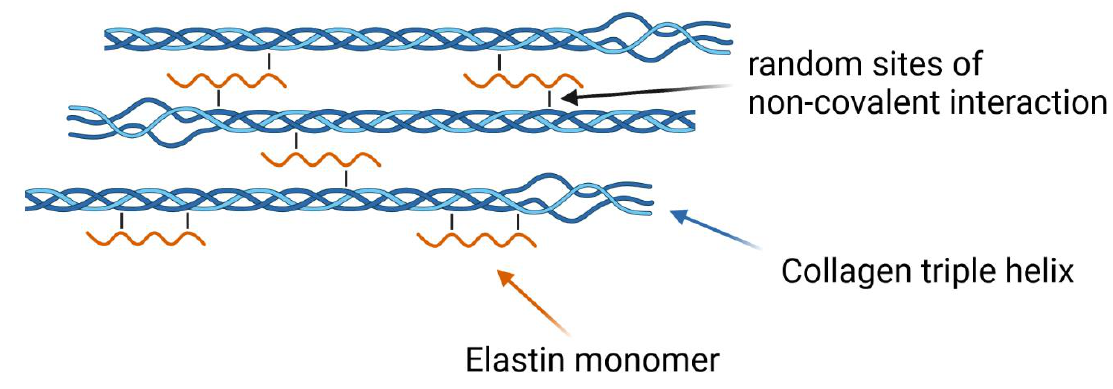
Figure 8. Proposed incorporation of elastin into a collagen fibril (hydrophilic and hydrophobic segments of elastin are not shown). The random coil ends of collagen should signify the suggested interference of elastin with collagen’s secondary structure during polymerization. Elastin monomers are thought to bind to collagen through local H-bonds, van-der-Waals bonds and ionic bonds, although the latter is less likely due to the low zeta potential.